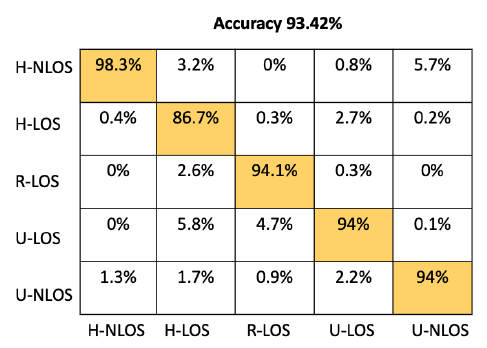
Figure 5. Confusion matrix based on LTS approach for the proposed